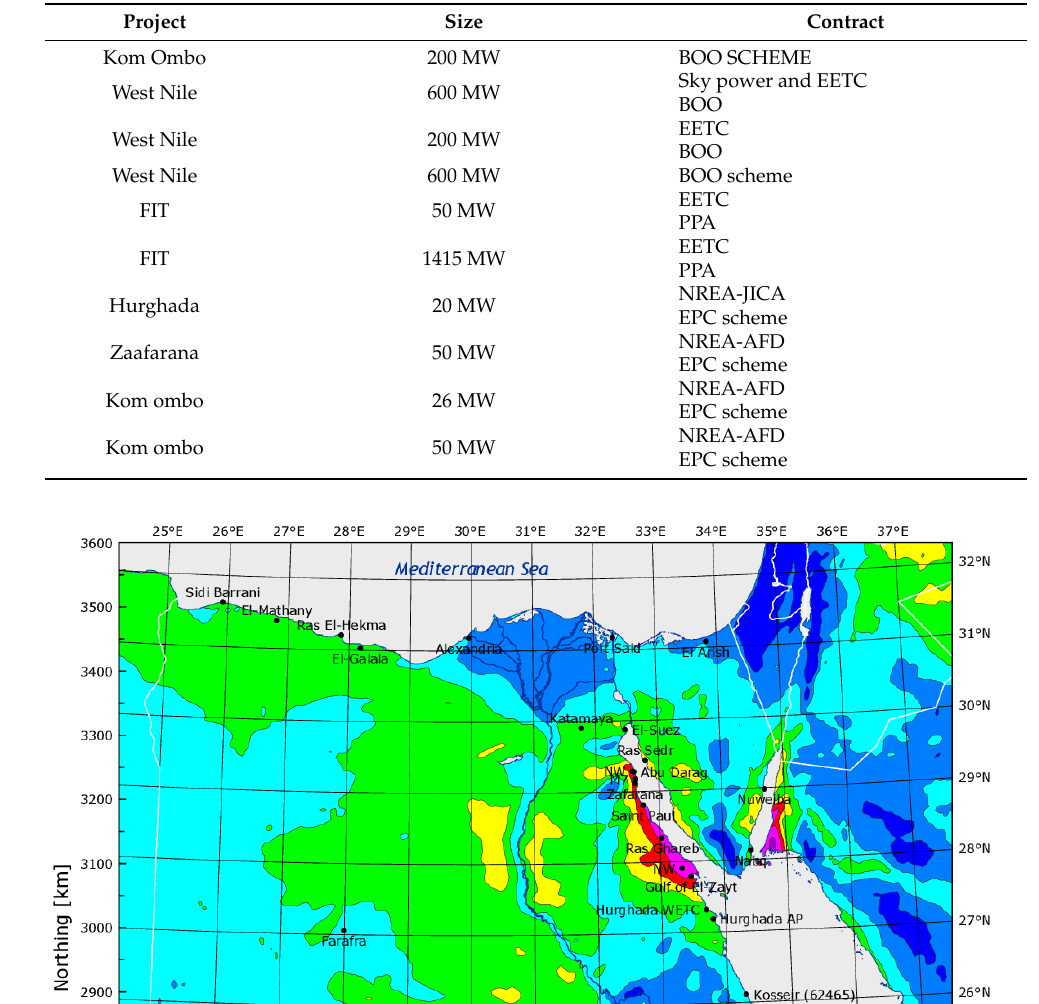
Table 2. New PV projects in Egypt.